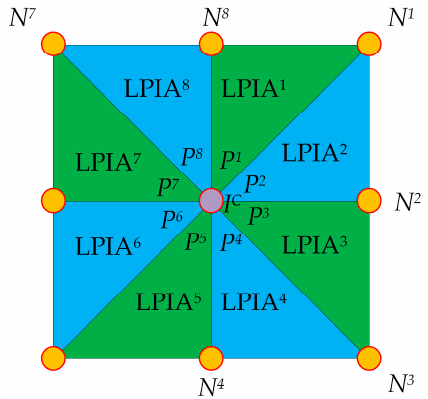
Figure 2. Multi-directional LPIA diagram.